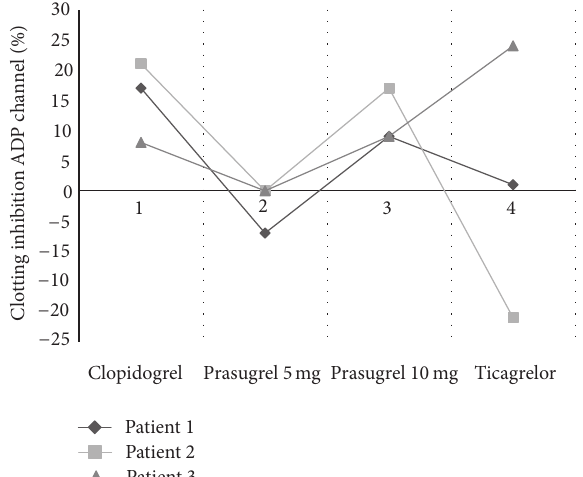
Figure 3: Variability in % clotting inhibition following medication adjustments in patients found to be hyporesponsive at initial and successive short TEG tests following stent thrombosis. Horizontal dotted line signifies a sufficient